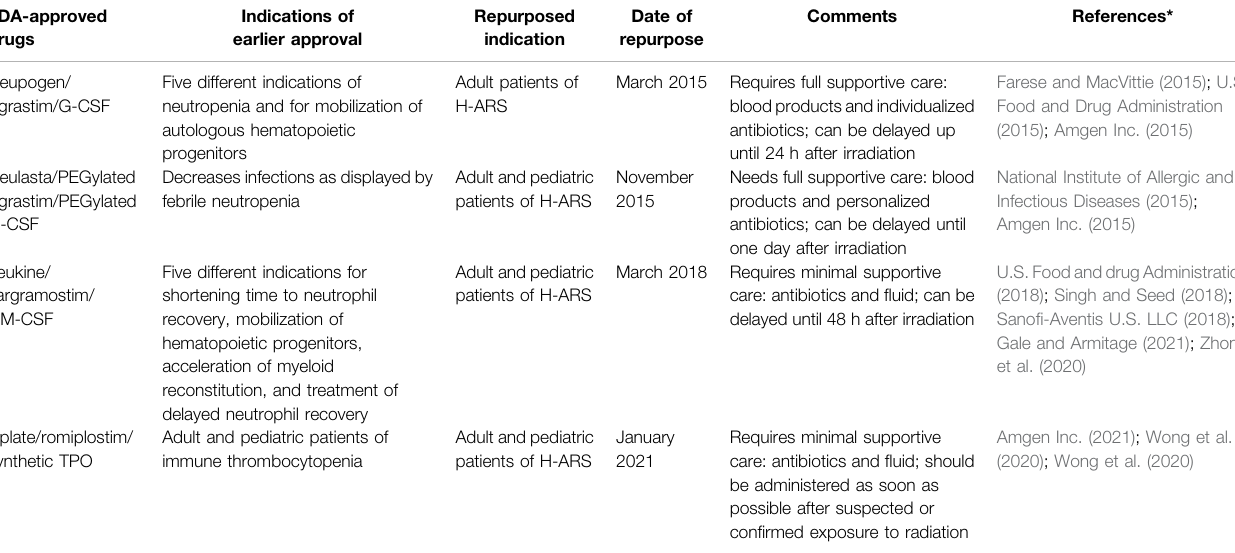
TABLE 1 | US FDA-approved growth factors for other indications repurposed for H-ARS as